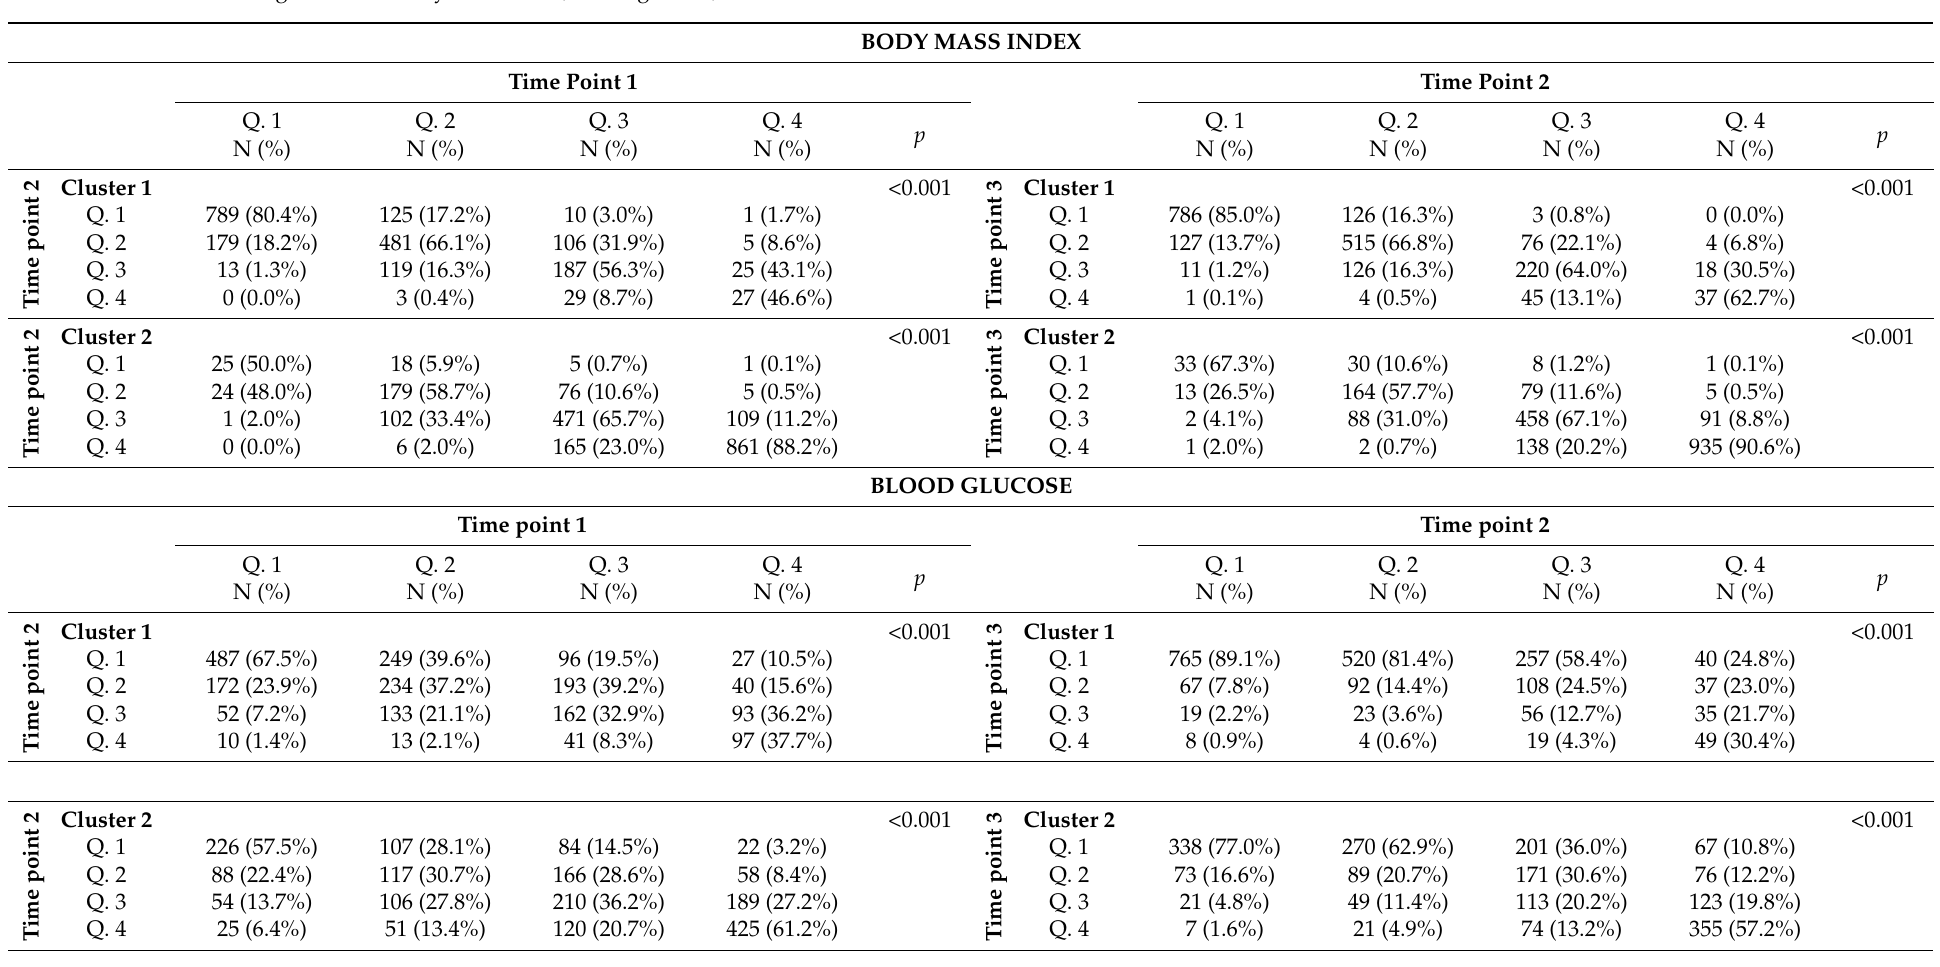
Table A2. Results of the quartile analysis by clusters. Values represent the percentage of individuals that moved from one quartile to another between time points 1 and 2 and time points 2 and 3 for the following variables: body mass index, blood glucose, and cardiovascular disease risk